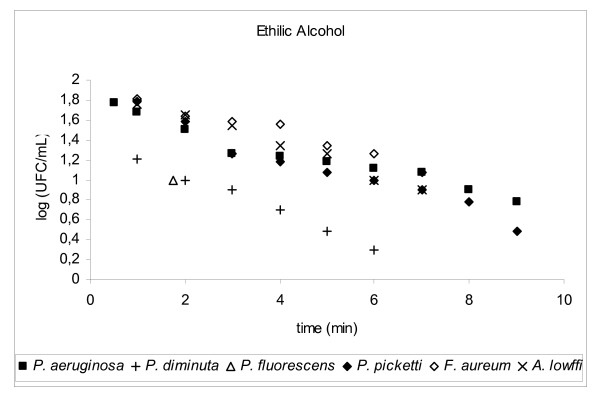
Graphic representation of the standard and in house microorganism reduction against different sanitizers.